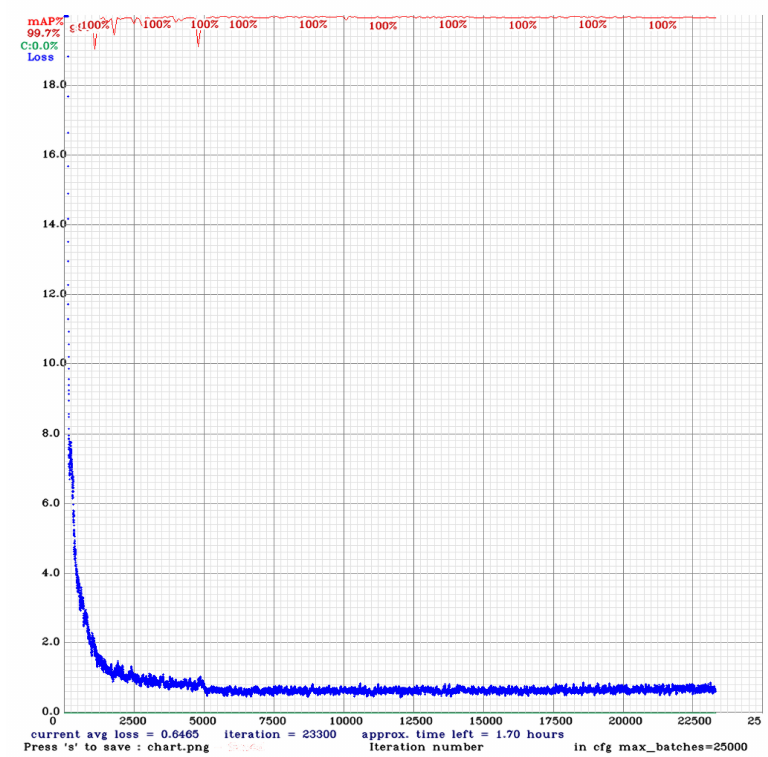
Figure 15. The performance of YOLOv4 on the simple aerial trash dataset.